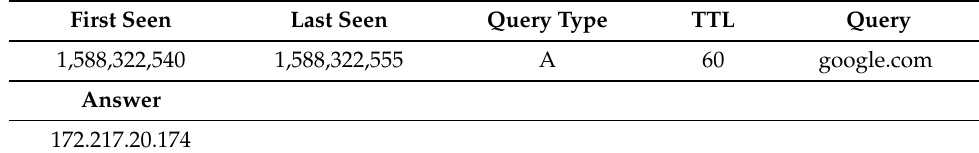
Table 4. Exemplary output of the Passive DNS. Second view.